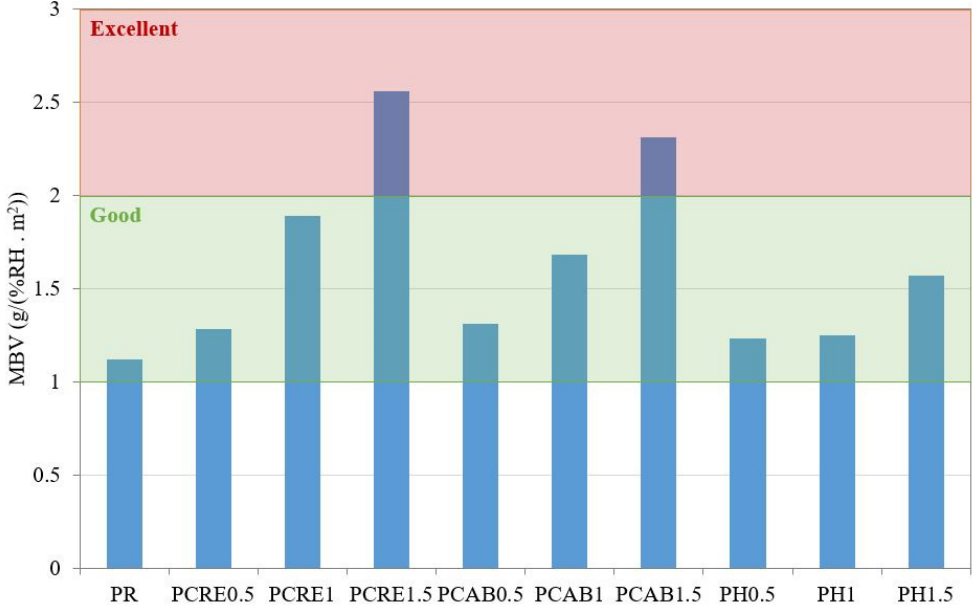
Figure 6. Moisture buffer values of studied plasters.